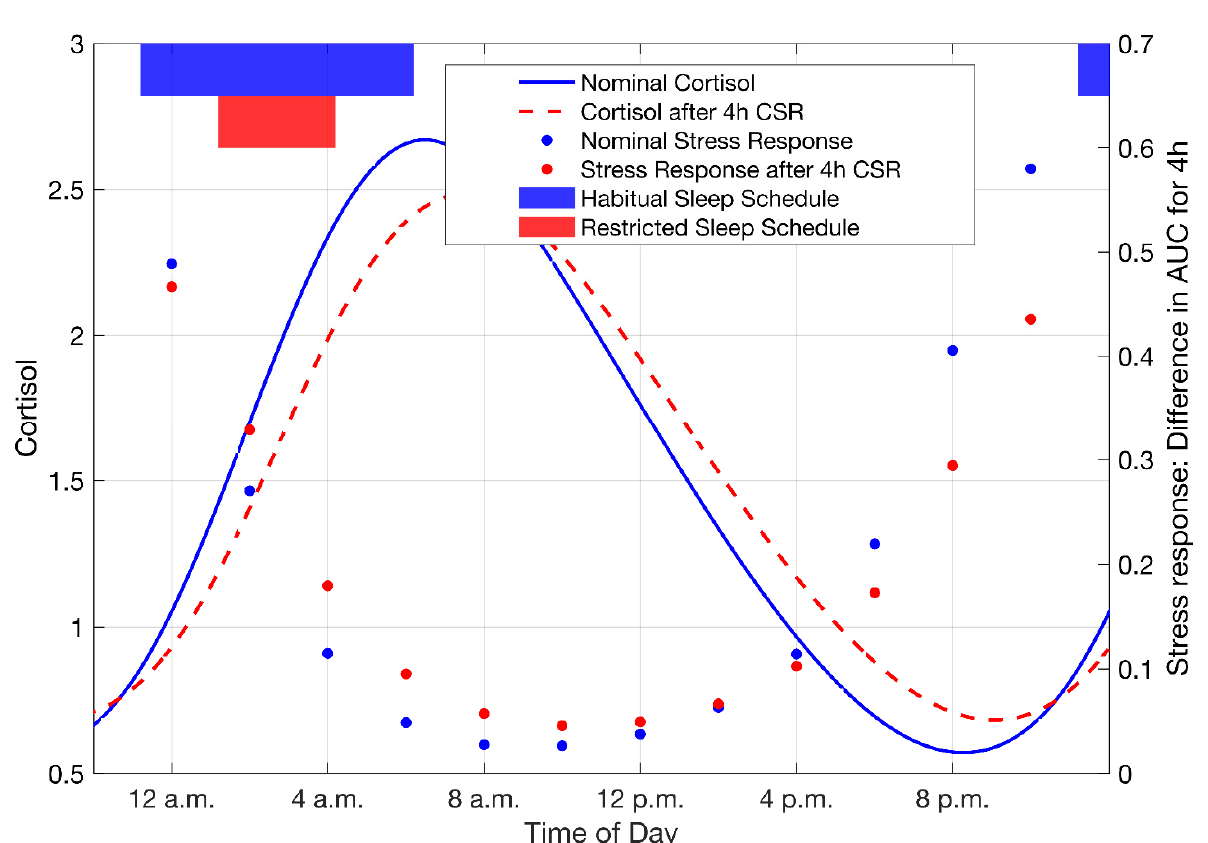
Figure 8. The influence of 4 h of CSR on the stress response of the HPA axis. The nominal cortisol profile (blue) in comparison to the cortisol rhythm after 4 h CSR (red). The timing of the sleep episodes is depicted by the blue (habitual) and red (CSR) bars at the top of the figure. The glucocorticoid acute stress response is calculated as the difference in AUC for 4 h between stressed and unstressed states for the two conditions. The dots depict the acute stress response, for the two conditions, at the indicated times at which the simulated acute stressor was administered.